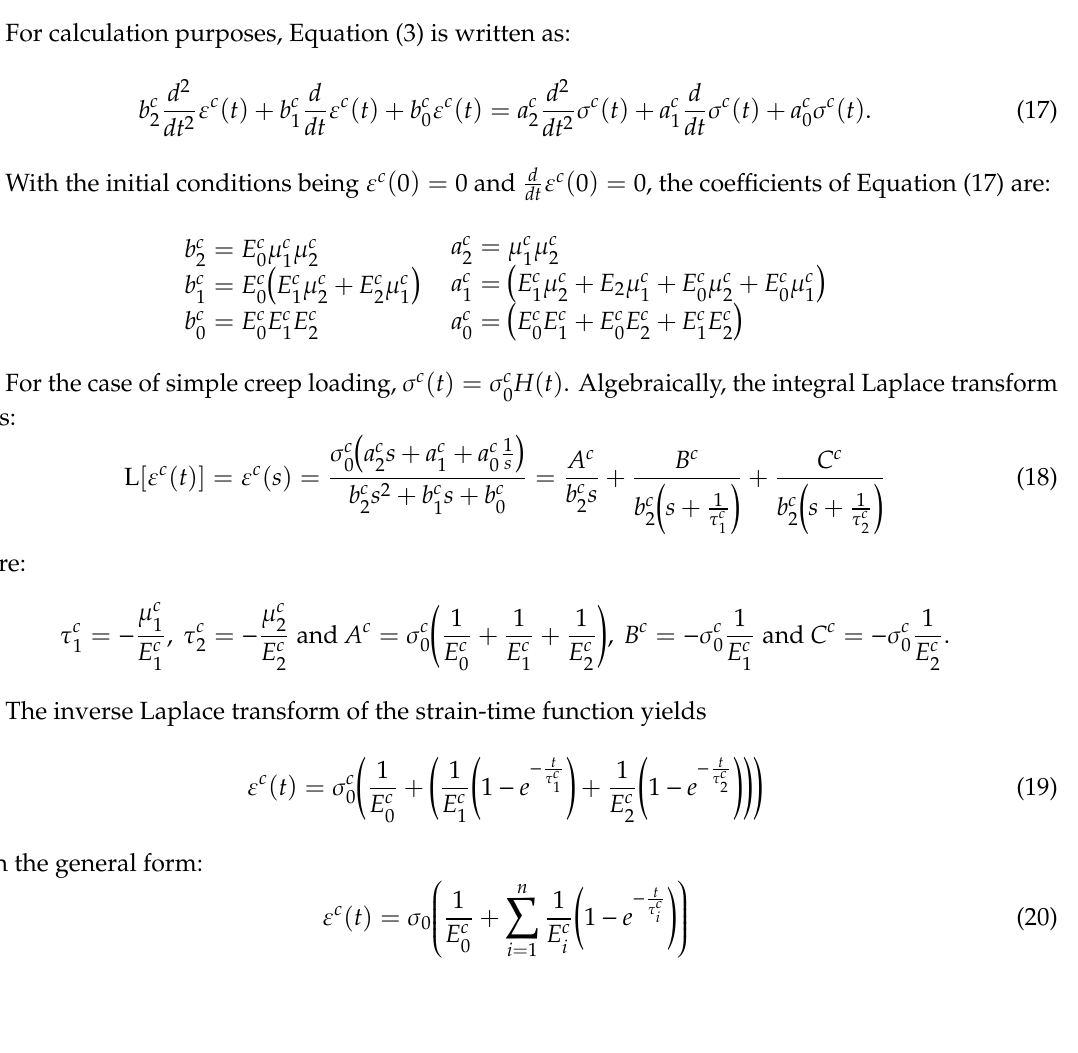
Figure 6. Kelvin–Voight creep model.